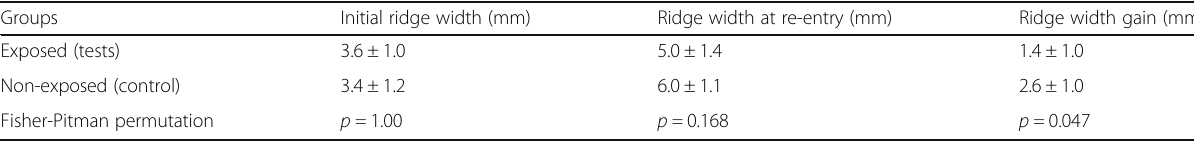
Table 2 Baseline and re-entry measurement of the alveolar ridge width Groups